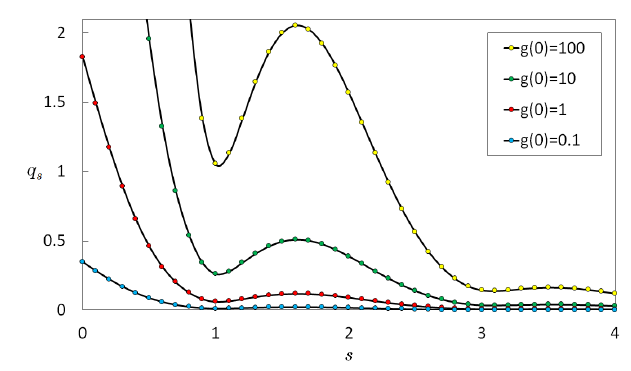
Figure 1. Dependence of the variational functions q s on s for different values of the parameters of width w and ε . At the same time, we chose the following system of units: the product as well as the width of the basis functions ψ s ( x ) .